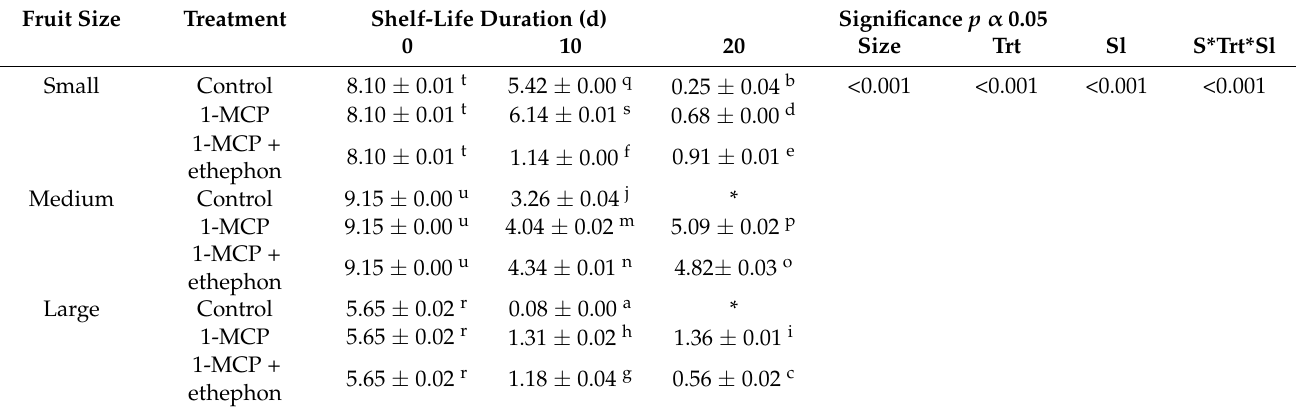
Table 2. Effect of fruit size, 1-MCP treatments, and shelf-life and their interaction on starch concentration during shelf-life at ambient